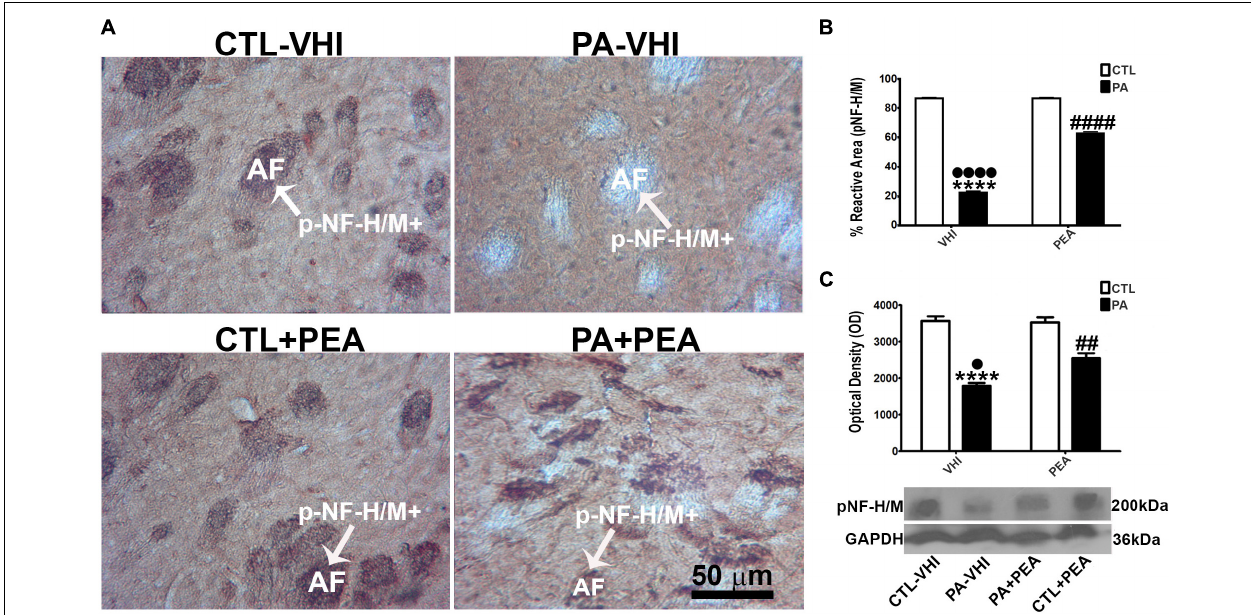
FIGURE 1 | Phosphorylated neurofilament-heavy/medium-chain (pNF-H/M) immunostaining and protein level in the rat striatum in the experimental groups. (A) Representative images of dorsal striatum immunostained for pNF-H/M. The white arrow indicates the positive immunostaining area for pNF-H/M; AF indicates the axonal fascicles. Strictly dorsal striatum was used for immunohistochemistry due to its high vulnerability to hypoxia. Scale bar: 50 µ m. (B) Percentage of pNF-H/M reactive area. (C) Optical density of bands showing pNF-H/M protein expression level. Bars and error bars represent the mean ± SEM. Two-way ANOVA followed by Tukey’s post hoc test. ∗∗∗∗ p < 0.0001, PA–VHI vs. CTL–VHI, •••• p < 0.0001, and • p < 0.05, PA–VHI vs. PA+PEA; #### p < 0.0001 and ## p < 0.005, PA+PEA vs. CTL–VHI. PEA did not affect either pNF-H/M immunostaining or protein expression as there was no difference between CTL+PEA and CTL–VHI